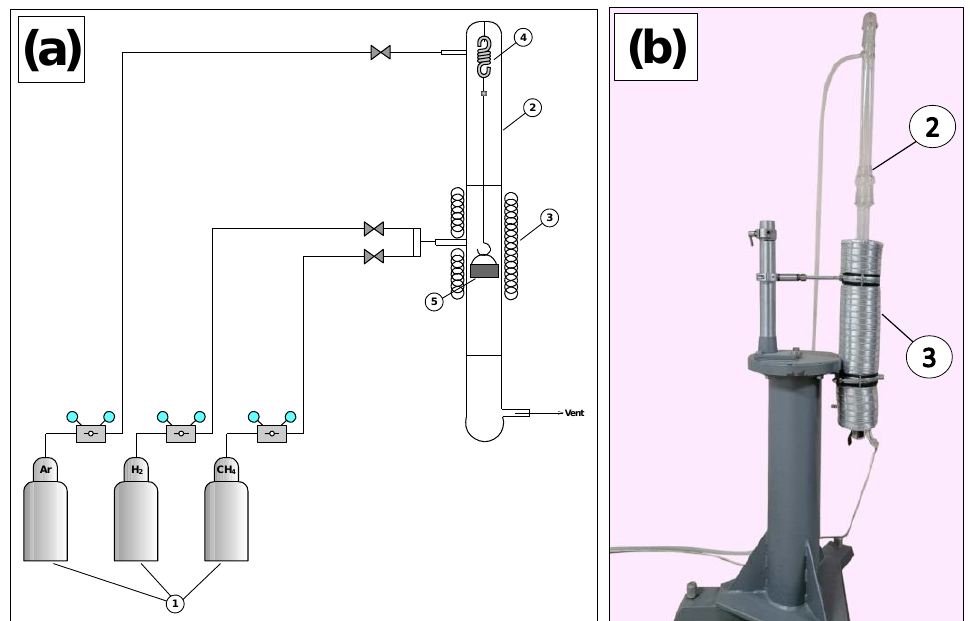
Figure 2. Schematic drawing of the setup applied for the kinetic studies ( a ) and exterior view of the reactor ( b ): (1)–vessels with gases; (2)–flow-through quartz reactor; (3)–furnace; (4)–quartz spring; (5)–quartz basket with the sample.